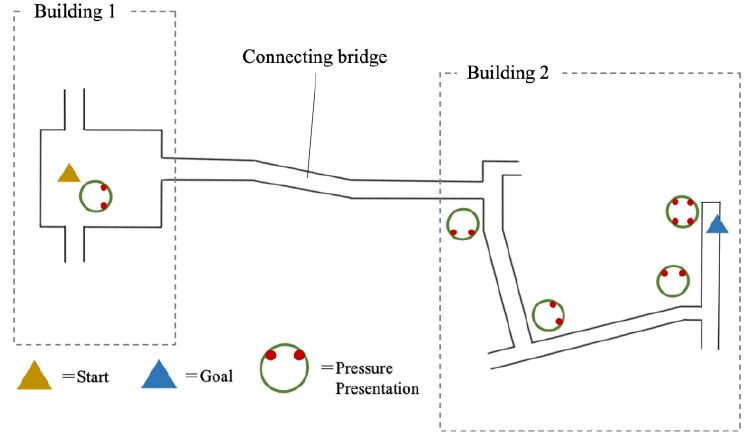
Figure 9. Walking route and the spots where pressure is presented in the user study.